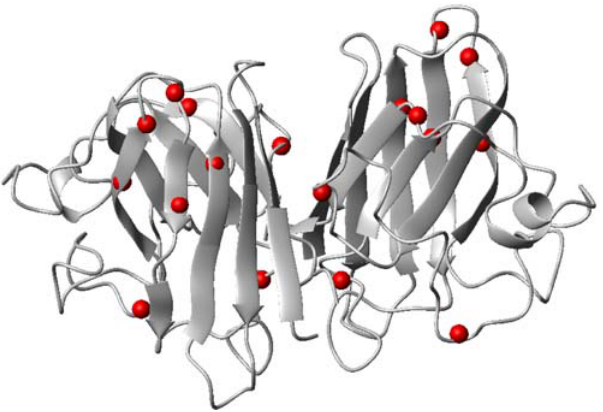
Figure 1. SOD1 investigated mutations. Location of the investi- gated mutations (red spheres) mapped on the (Cu,Zn) WT SOD1